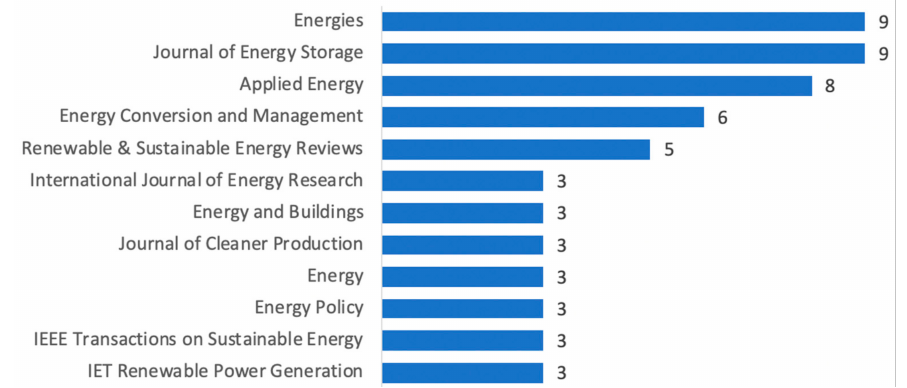
Figure 4. Most frequent journals in the